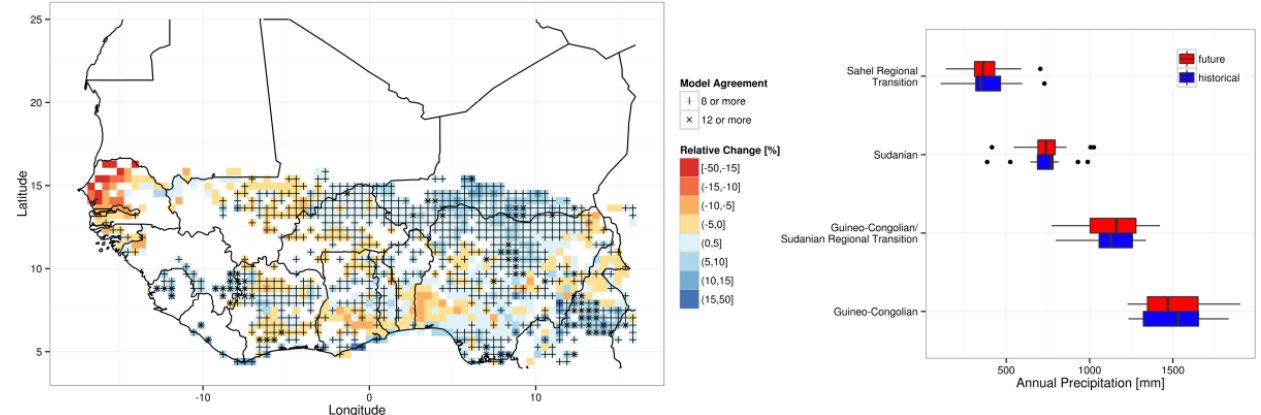
Figure 6. Relative change in ensemble median precipitation (left) and simulated absolute values of long term annual historical and future precipitation for 16 RCM/GCM combinations aggregated for 4 vegetation zones (right). “ + ” indicates an agreement of 8 or more models in the direction of change, “*” indicates an agreement of 12 or more models. Boxes extends from the 25th to 75th percentiles, whiskers indicate 1.5 times the interquantile range.